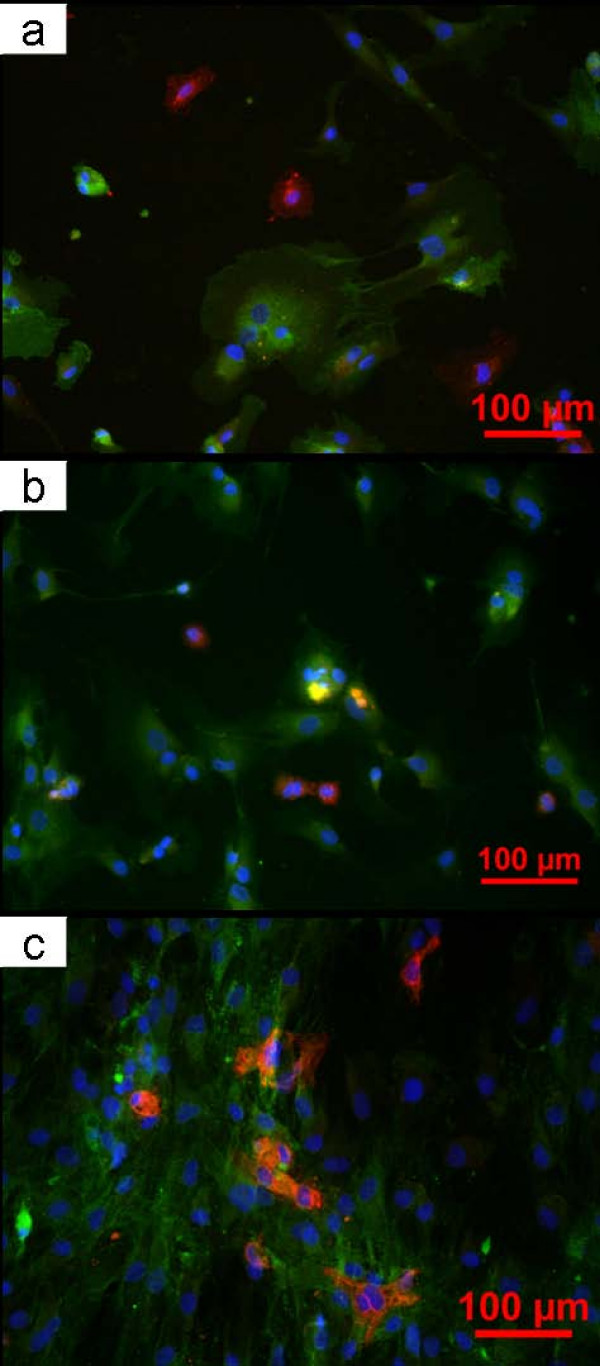
Cells grown on the coverslips for 1 (a), 3 (b) and 5 (c) days: MSC were labeled with CD90 (green), EC with UEA I (red) and nuclei with DAPI (blue).